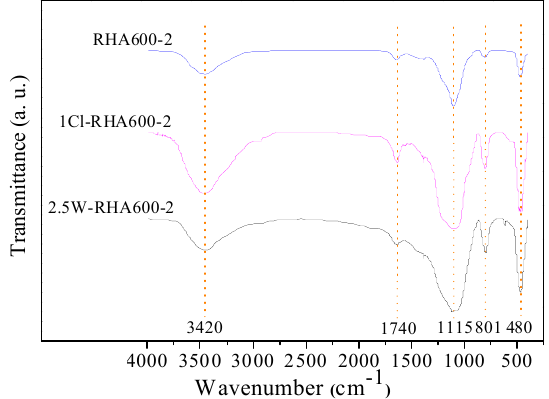
Figure 4. FTIR spectra of RHA with and without various pretreatments.